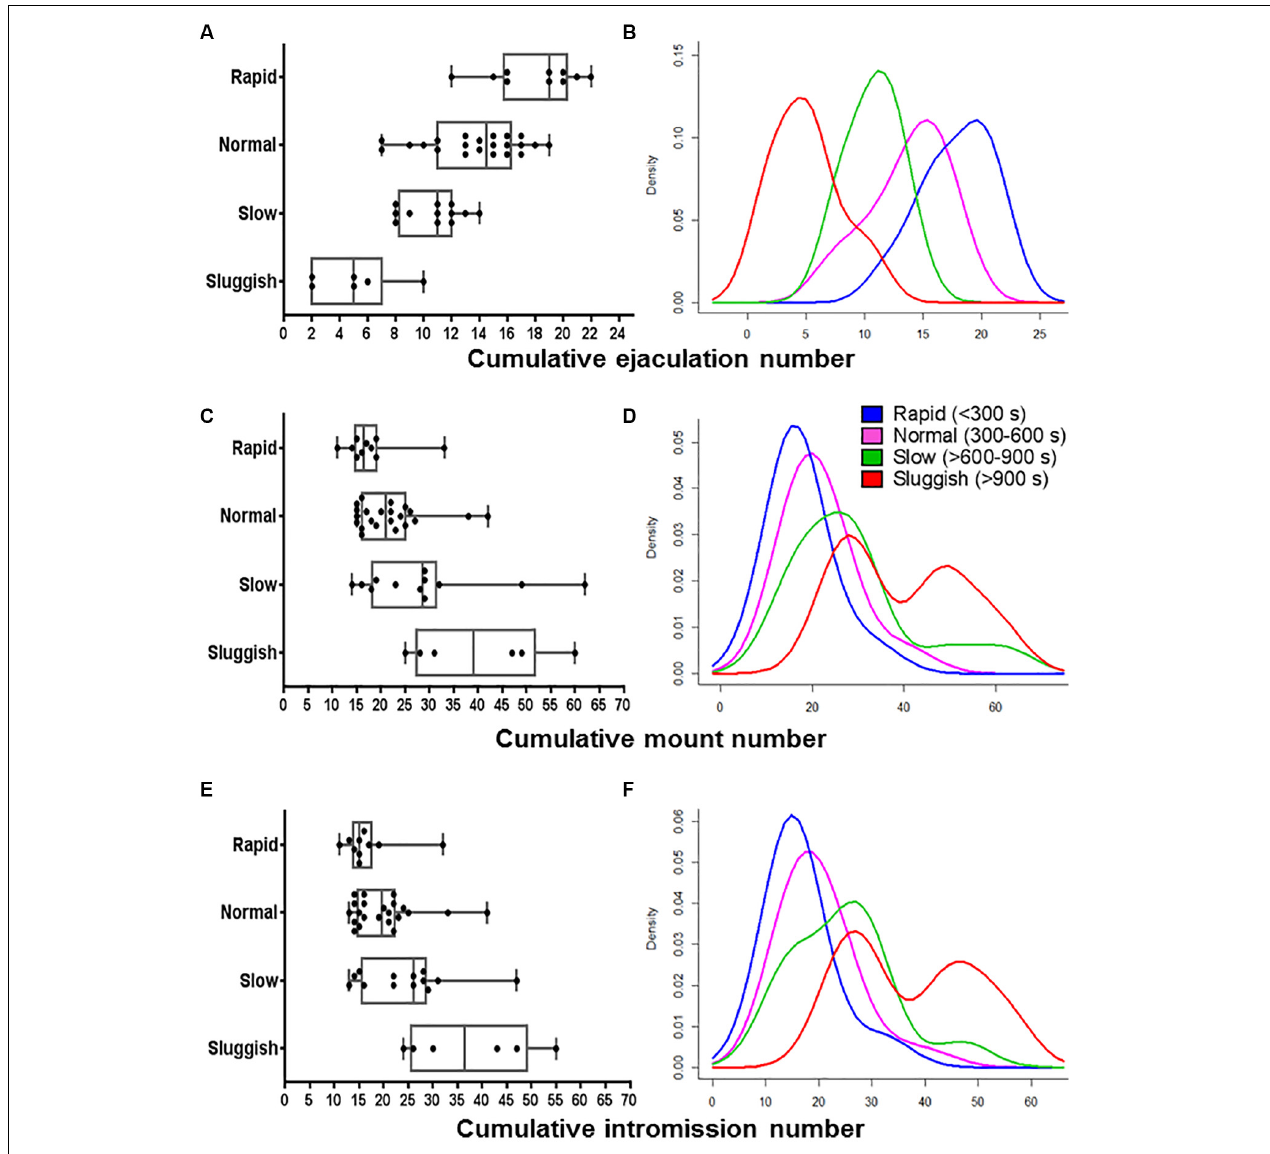
FIGURE 2 | The internal consistency of the presumed EL-ejaculatory endophenotypes is compromised by introducing any other copulatory parameter in addition to EL as phenotyping variate. Boxplots (A,C,E) and probability density plots (B,D,F) allowed us to evaluate the internal consistency of the presumed cumulative ejaculation number (A,B) , cumulative mount number (C,D) , and cumulative intromission number (E,F) . In contrast, when EL was paired with cumulative mount number (C,D) and cumulative intromission number (E,F) , a great deal of overlapping occurred among the presumed EL-ejaculatory endophenotypes.